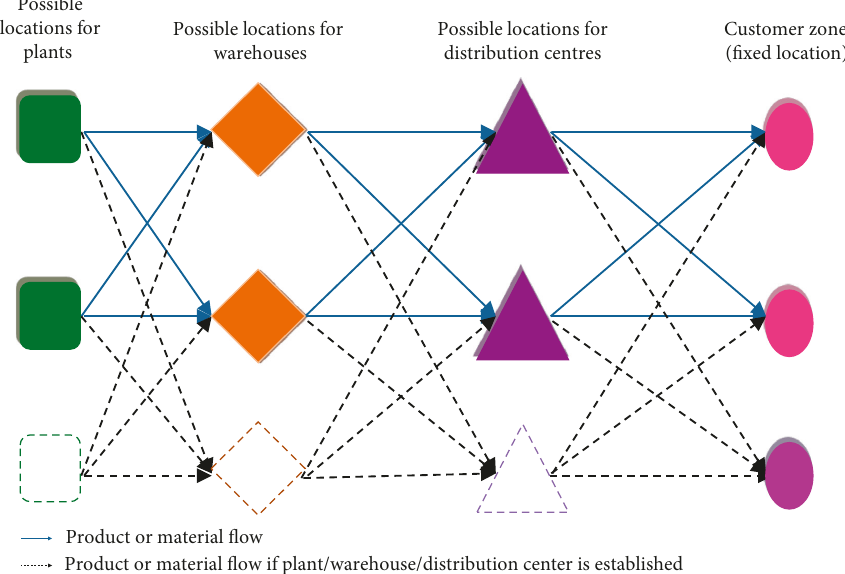
Figure 1: The supply chain network considered in the proposed